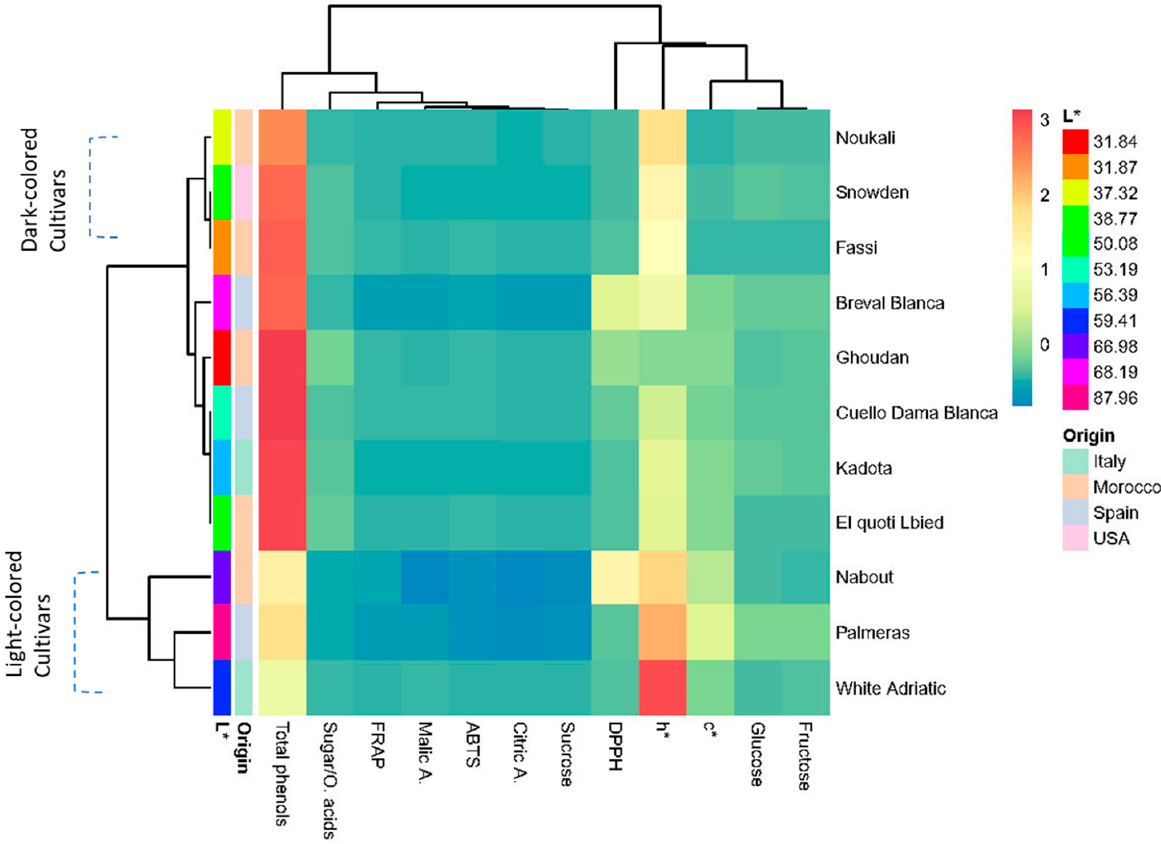
Figure 11. Two-dimensional hierarchically clustered heatmap based on the correlation matrix of the studied variables.